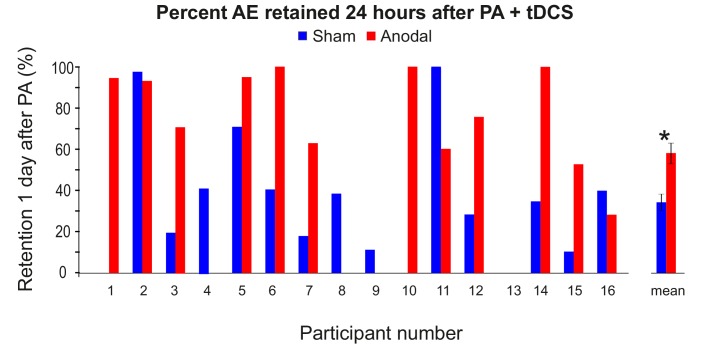
AE retention scores (%) 24 hr after PA was combined with anodal or sham tDCS in Experiment 7.Bars represent individuals and group mean ±1 SEM (N = 16). Apparently missing bars represent zero retention. Participants 1–10 also had usable MRS data and are shown in the behavior-neurochemistry correlation in Figure 4. Figure 4 plots the anodal-sham difference in retention ratios.